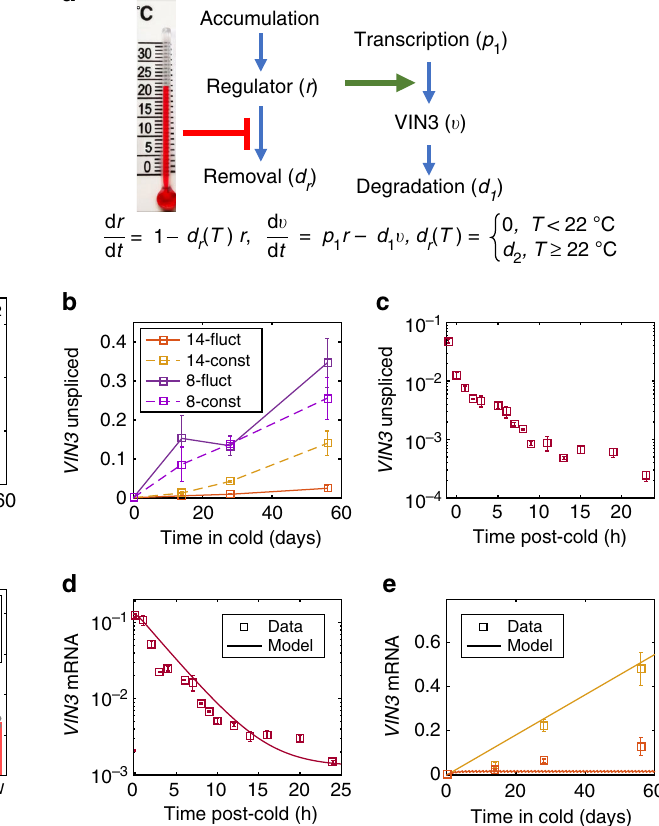
Fig. 2 FLC and VIN3 expression respond to temperature extremes rather than averages. a Temperature pro fi les of treatments used in the experiment. b , c VIN3 and FLC mRNA from Col FRI SF2 plants treated with ‘ cold ’ temperature conditions of panel a . For VIN3 , plants were sampled 5 – 7 h after dawn. b n = 3 − 6, average > 5.3. c n = 16 – 21, average > 19. d FLC mRNA in the mutant vin3 – 4 , otherwise as for c . n = 9 – 21, average > 17. e FLC mRNA in Col FRI SF2 during (T0) and after removal (T7, T20) from the 14.2 °C constant (14-const) or fl uctuating (14- fl uct) conditions shown in a , Tx = x days after return to warm, W = weeks in cold. n = 2 shown as grey circles. Error bars = s.e.m. In b − e RNA levels were normalised to UBC , PP2A